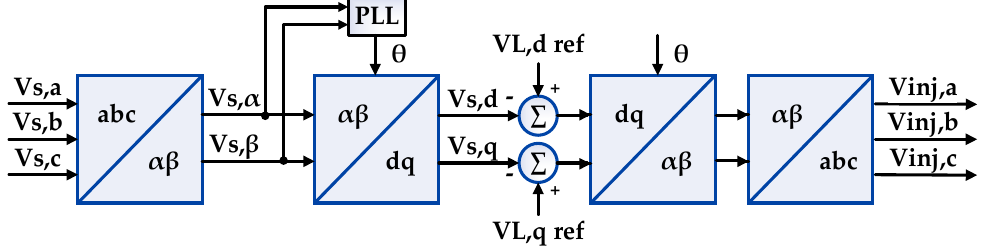
Figure 12. Voltage reference generation with Clark and Park transformations. Based on data from [69]. Table 9. Comparison between Feedback, Feed-forward, and Composite controllers. Based on data from [138].